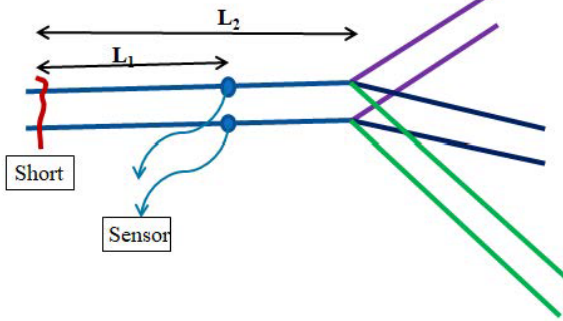
Figure 21. The sensor is between the short and the bifurcation